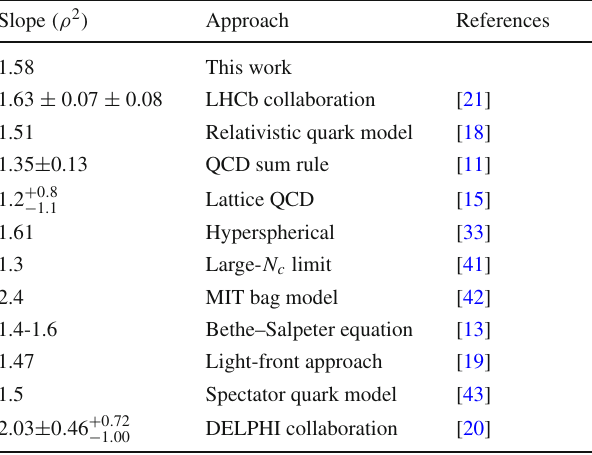
Table 3 Predictions for the slope at zero recoil of the baryonic Isgur- Wise function ξ(ω) Slope (ρ 2 )